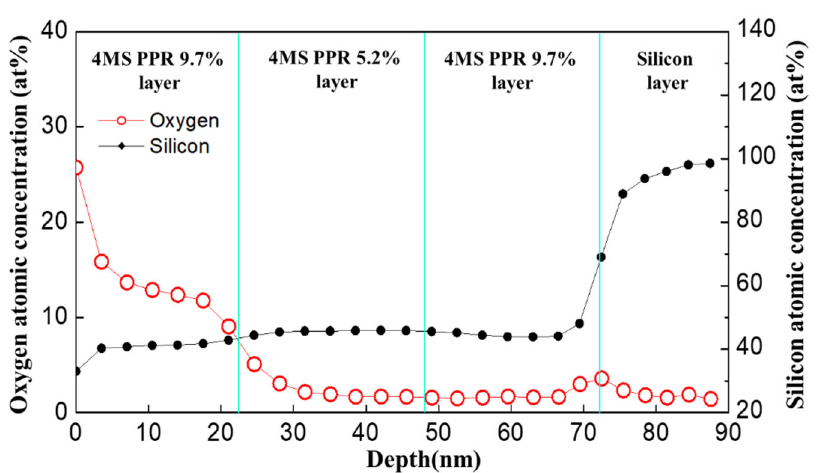
Figure 5. Results of XPS in-depth analysis for three-layered film with 4MS PPR 9.7%, 4MS PPR 5.2%, and 4MS PPR 9.7%.